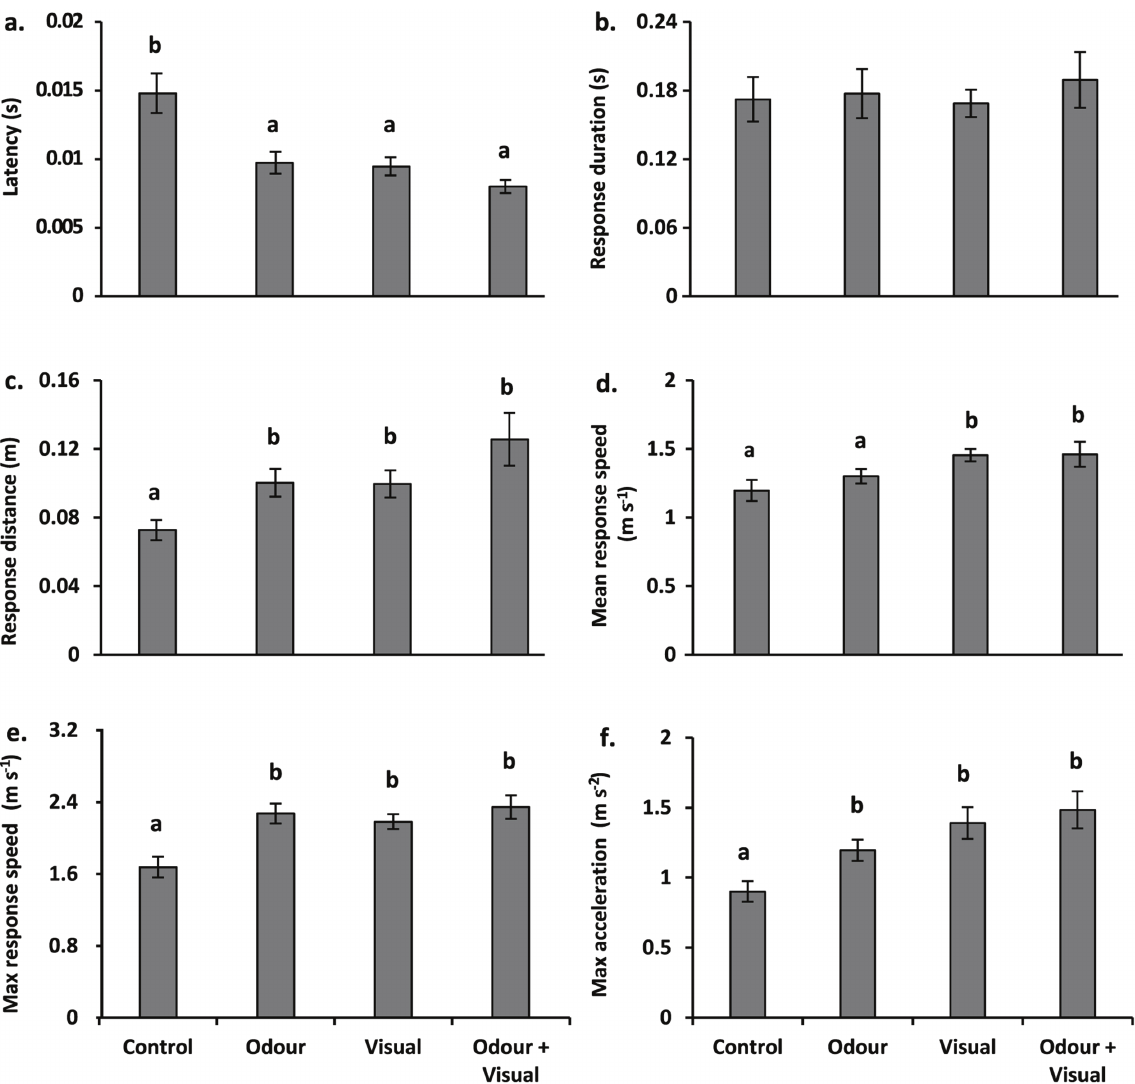
Fig 1. Comparison of fast-start kinematics of juvenile Acanthochromis polyacanthus to 3 predator cues and controls. (a) latency (s), (b) response duration (s), (c) response distance (m), (d) mean response speed (m s -1 ), (e) maximum response speed (m s -1 ), and (f) maximum acceleration (m s -2 ) ( ± S. E.). n =